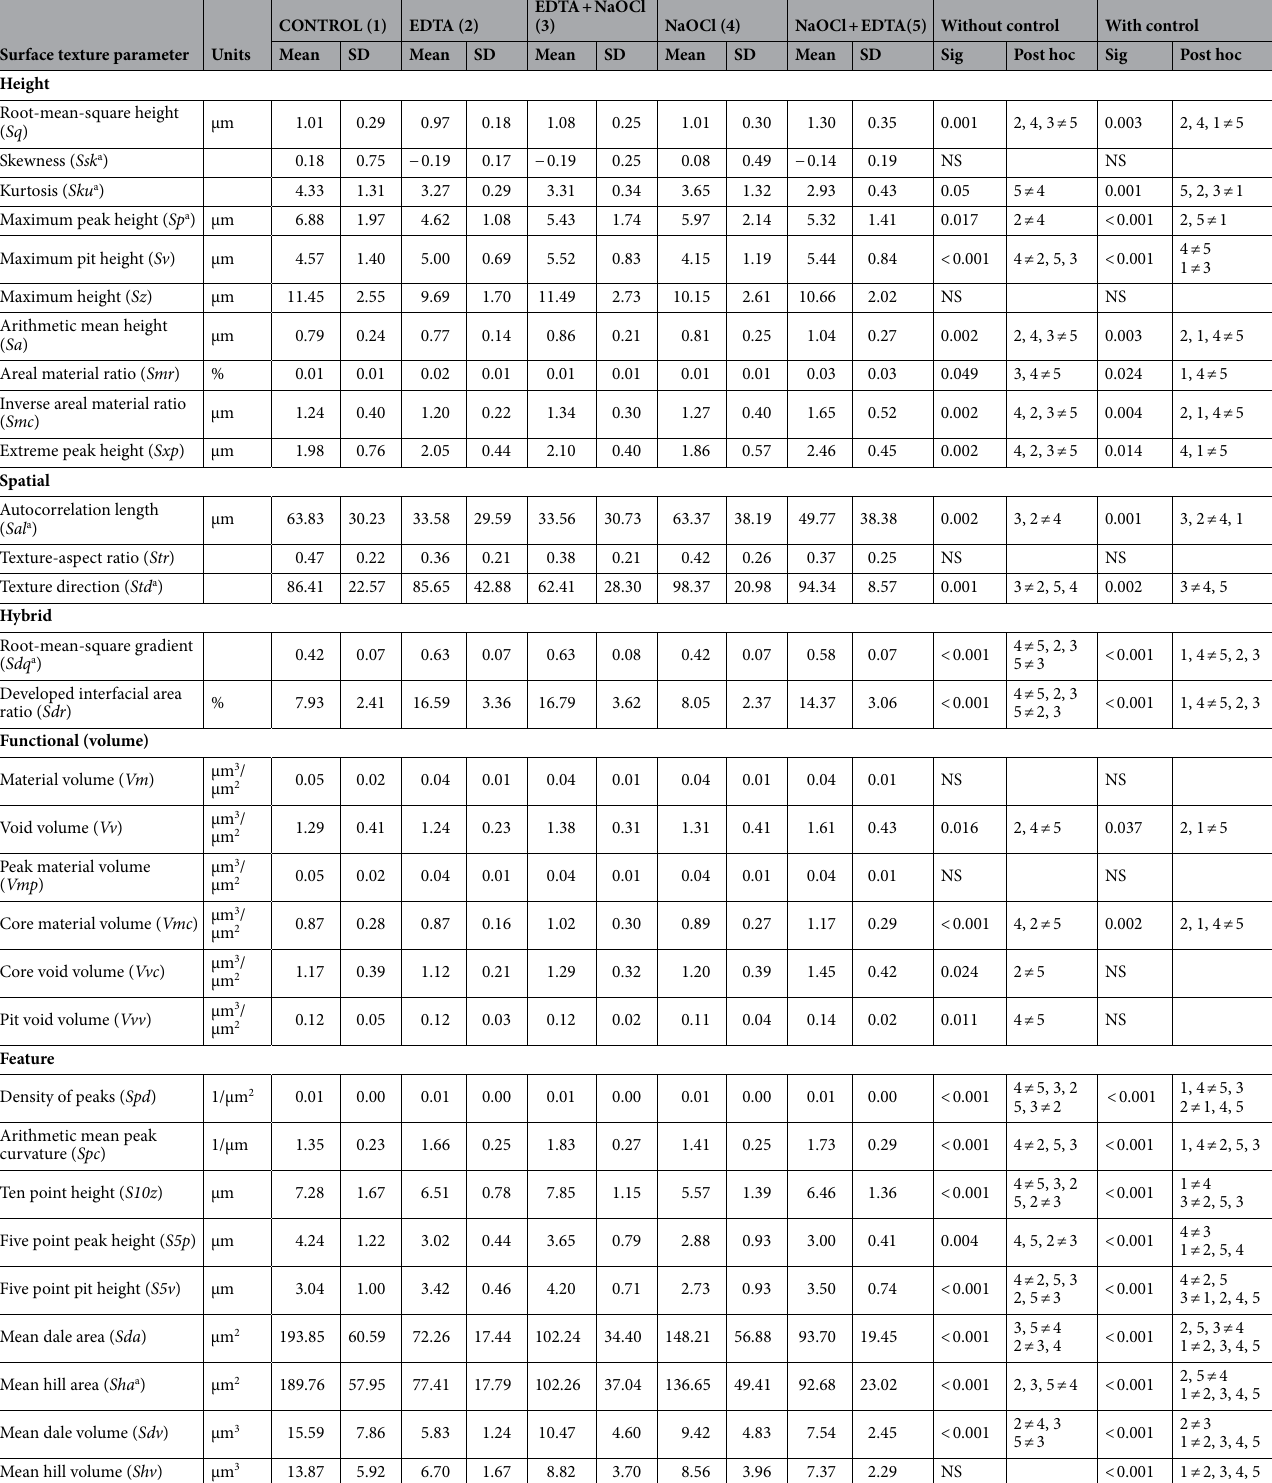
Table 1. Descriptive statistics (mean, standard deviation = SD) are given for surface texture parameters (ISO 25178-2) measured of the five groups (1—CONTROL, 2—EDTA, 3—EDTA + NaOCl, 4—NaOCl, 5—NaOCl + EDTA). p -value for zone-wise comparisons resulting from the ANOVA are shown, level of significance was set to p < 0.05 and Post Hoc (Tukey) analysis show the significant differences between the three areas. a Larger value shows less